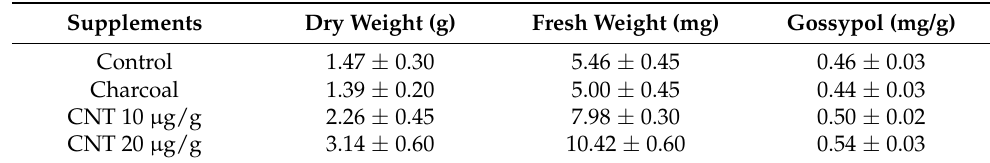
Figure 2. Growth parameter of cotton cell suspension culture after one month: ( A ) biomass accumu- lation in MS supplemented with ( a ) no supplements, ( b ) 10 µg/mL CNT, ( c ) 20 µg/mL CNT, and ( d ) charcoal; ( B ) image was captured after removing media through filtration with filter paper, with ( a ) no supplements, ( b ) 10 µg/mL CNT, ( c ) 20 µg/mL CNT, and ( d ) charcoal. The image clearly shows the enhancement of biomass accumulation in CNT media. Table 1. Growth parameter and gossypol content of cell suspension culture after one month.